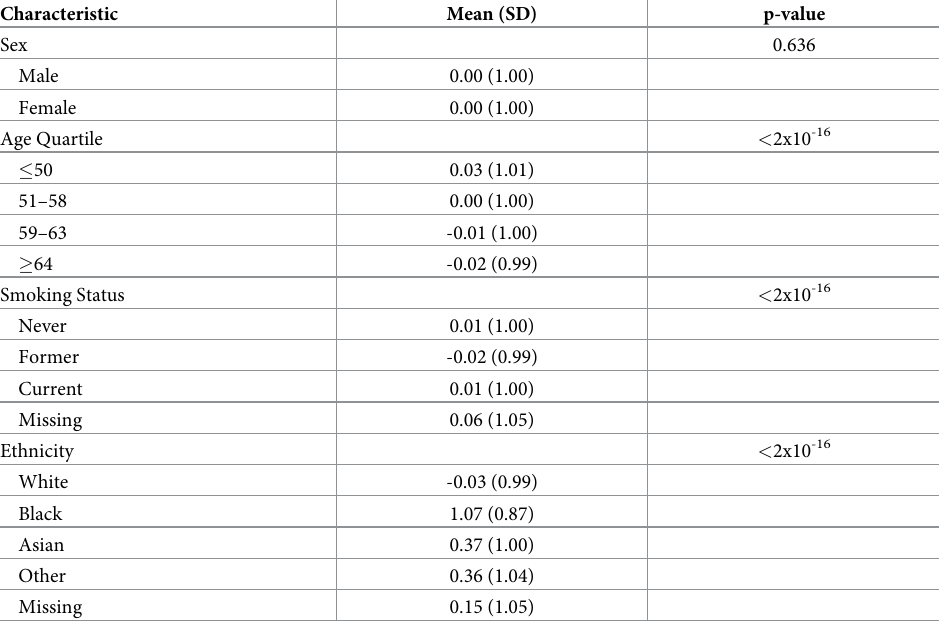
Table 1. Genetically-predicted telomere length by UK Biobank population